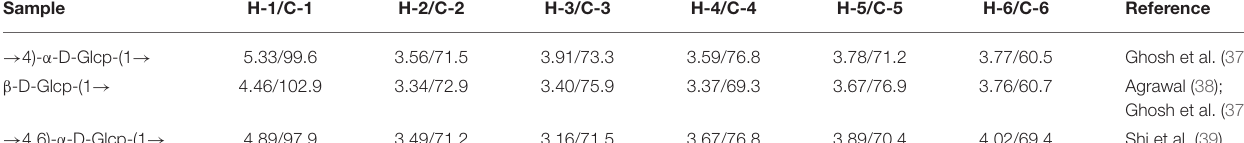
TABLE 2 | 13 C and 1 H NMR chemical shifts (ppm, δ ) for PSP-1.